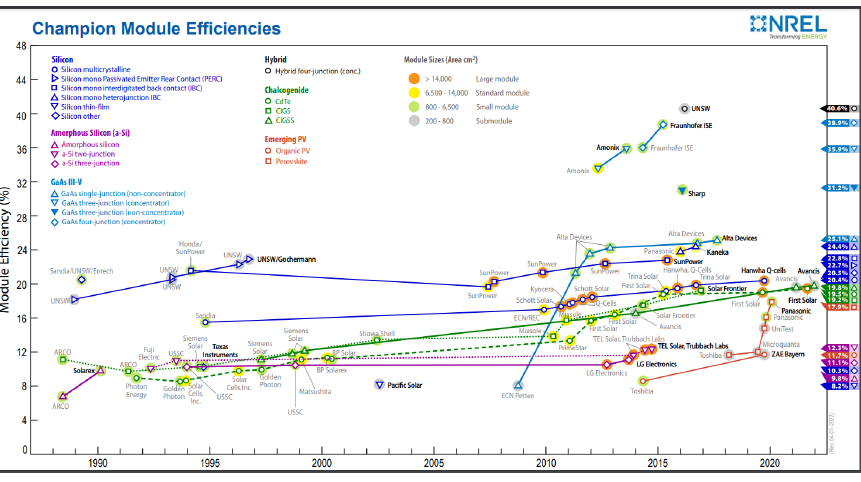
Figure 10. Champion photovoltaic module efficiency chart [4].